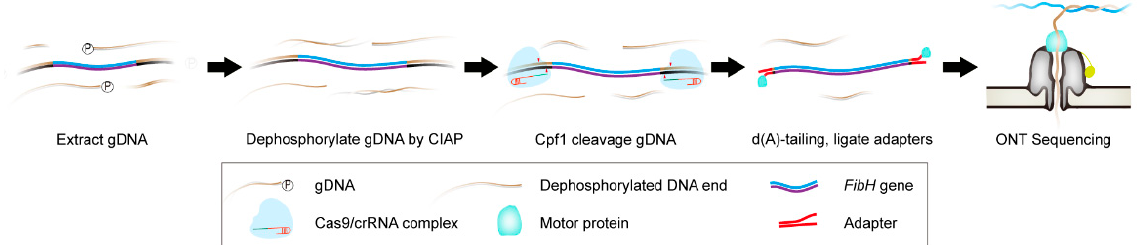
Figure 1. Overview of Cpf1-based enrichment and ONT sequencing (CEO) strategy. CEO mainly includes the dephospho-